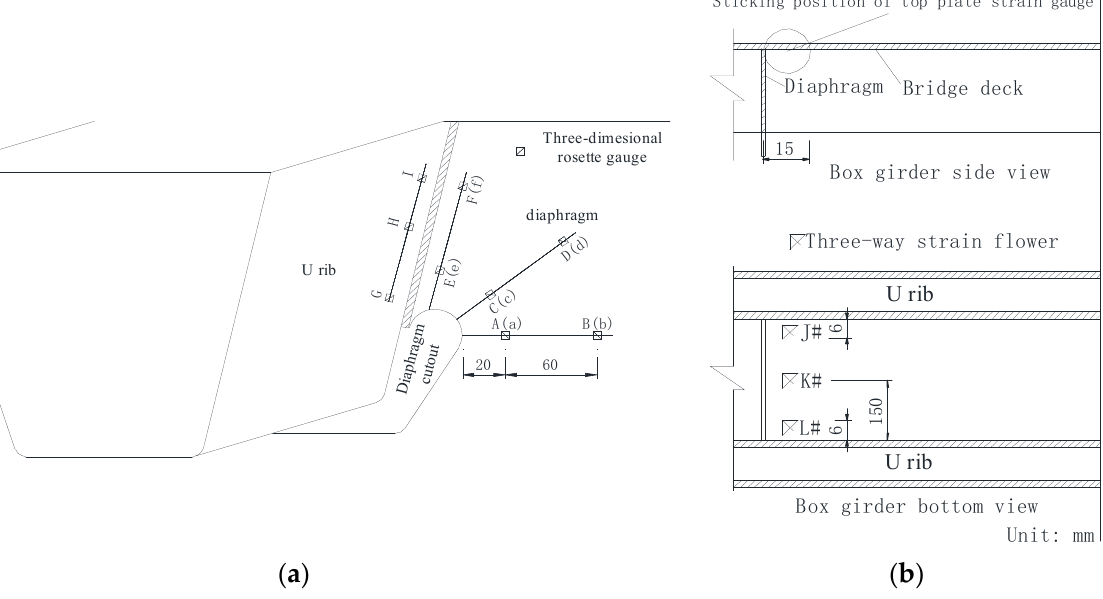
Figure 11. Schematic diagram of measuring points for vulnerable parts of steel box girder: ( a ) Measuring point on the side of the diaphragm and U-rib, ( b ) bridge deck measuring point.